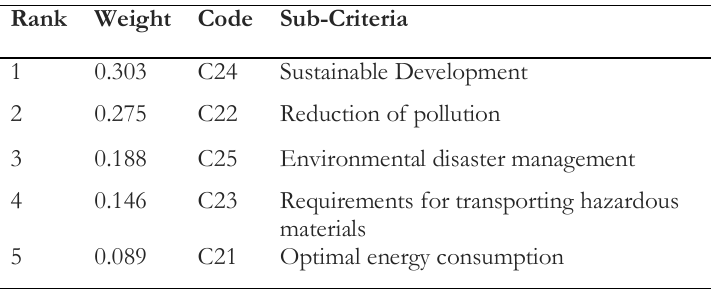
Table 7. Weight and rank of sustainable marketing